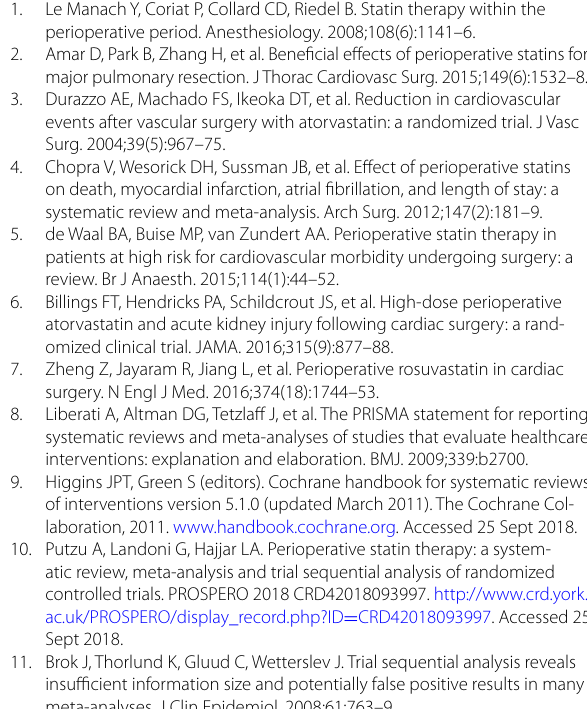
of bias graph. Figure 2 . Funnel plot for myocardial infarction. Figure 3 . Funnel plot for stroke. Figure 4 . Funnel plot for acute kidney injury. Figure 5 . Funnel plot for mortality. Figure 6 . Trial sequential analysis for postoperative myocardial infarction. Table 4 . Primary and secondary analyses. Table 5 . Sensitivity analyses. Table 6 . Postoperative outcomes in statin-naïve trials. Abbreviations AKI: acute kidney injury; CI: confidence interval; NNH: number needed to harm; NNT: number needed to treat; OR: odds ratio; RR: risk ratio; RRT : renal replacement